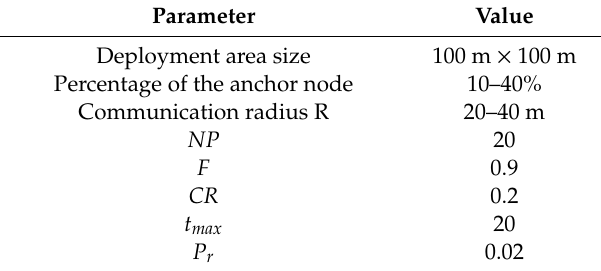
Table 1. Parameter settings of